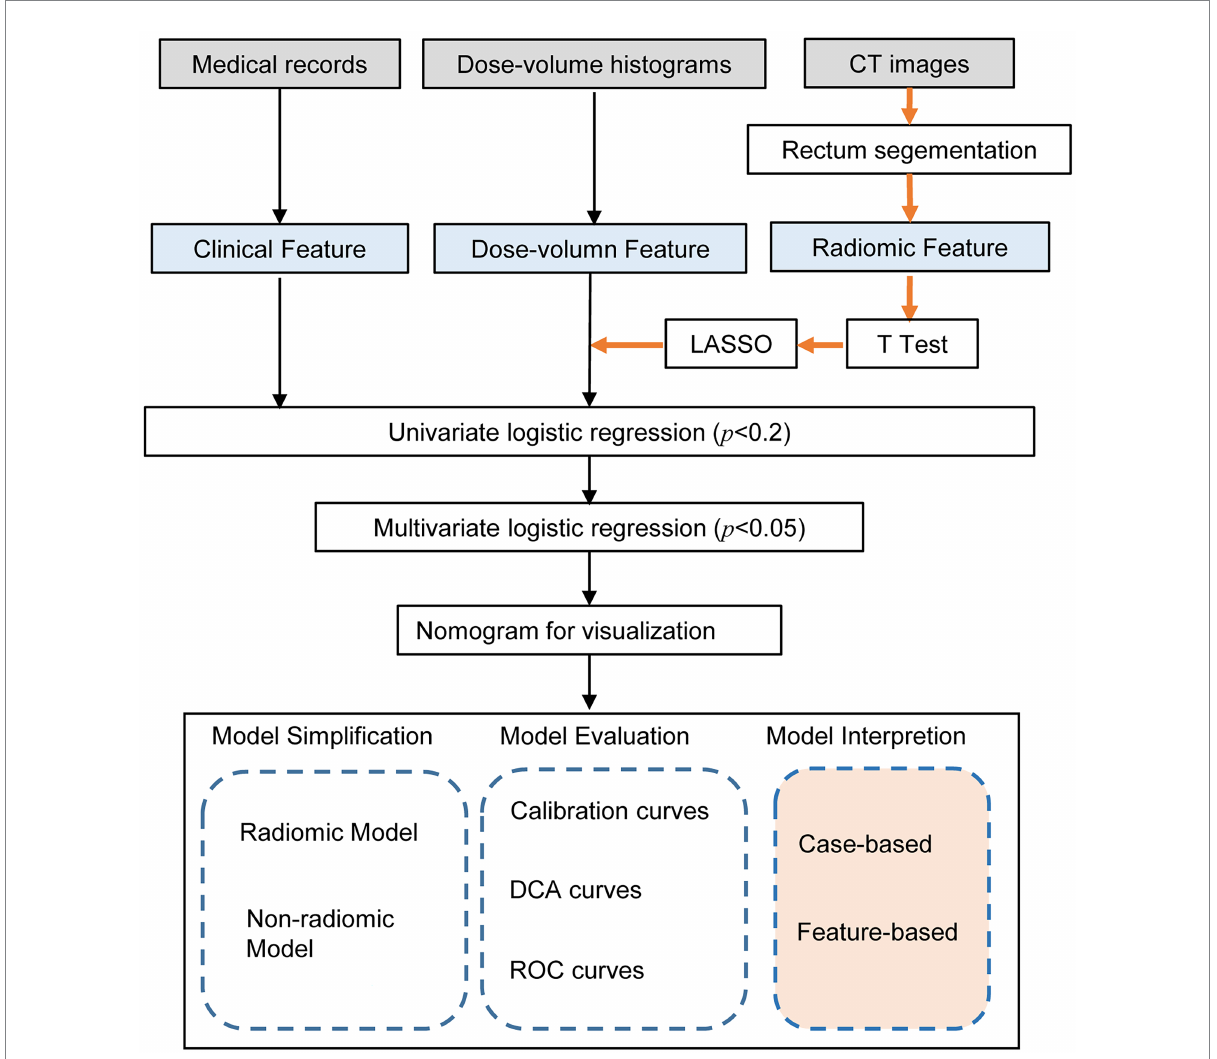
FIGURE 2 Workflow of the radiomic model development and model analysis process. The orange arrows in the flow chart represented the processing of the radiomic features. The radiomic features were generated by the PyRadiomics package after outlining the rectal region on the original image. After feature selection by T -test, LASSO and univariate logistic regression, multivariate logistic regression models were developed and visualized as nomograms. The model analysis consists of three parts: model simplification, model evaluation, and model interpretation. By comparing the performance change before and after model simplification, we could measure the importance of the radiomic features. In particular, we applied SHapley Additive exPlanation (SHAP) values for the first time to a radiomics-based logistic regression model to further interpret the radiomic features from case-based and feature-based